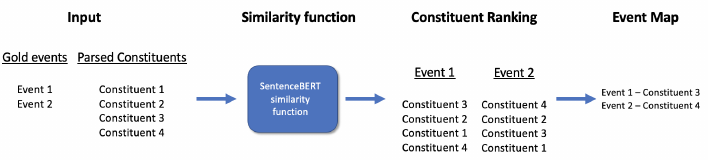
Figure 2. Visualization of the mapping of events and candidates in the same